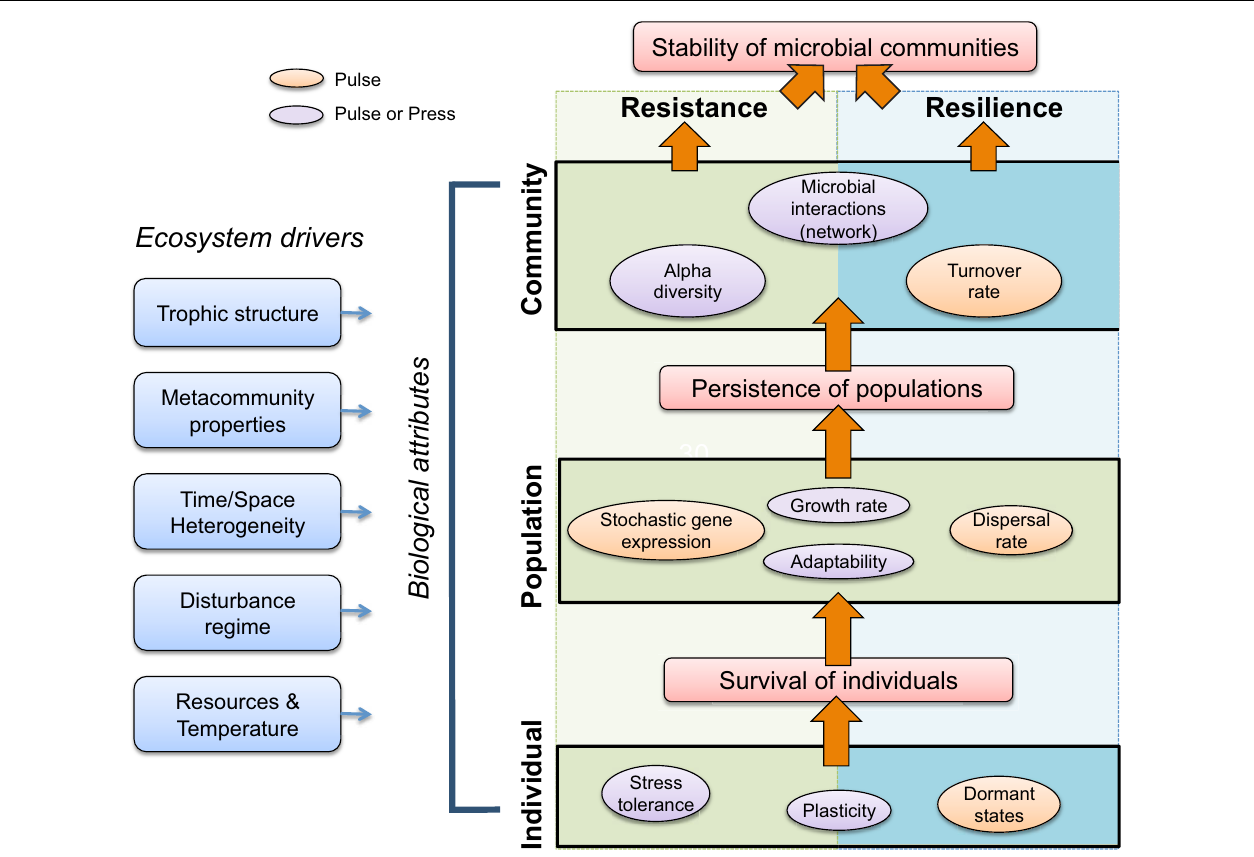
withstand or survive disturbances and promote persistence of populations, which in turn promote overall community stability (orange arrows). Ecosystem drivers (leftmost blue boxes), such as trophic structure and disturbance regime, shape biological attributes, and also contribute to resistance and resilience. Finally, we hypothesize that biological attributes will be differently advantageous given a pulse (orange or purple) or press (purple)